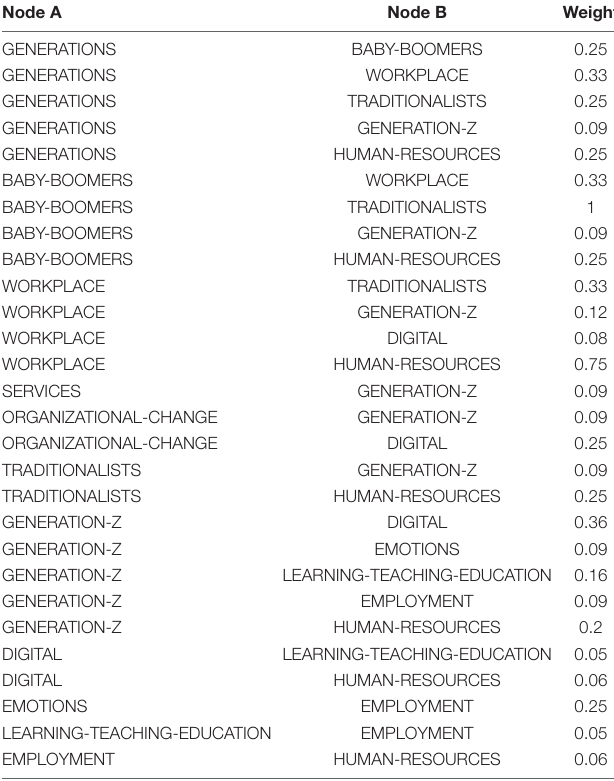
TABLE 6 | “Generation-Z” and Management cluster network